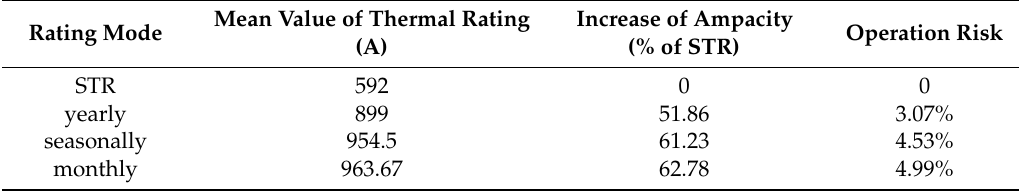
Table 4. Rating results analysis under 99% confidence